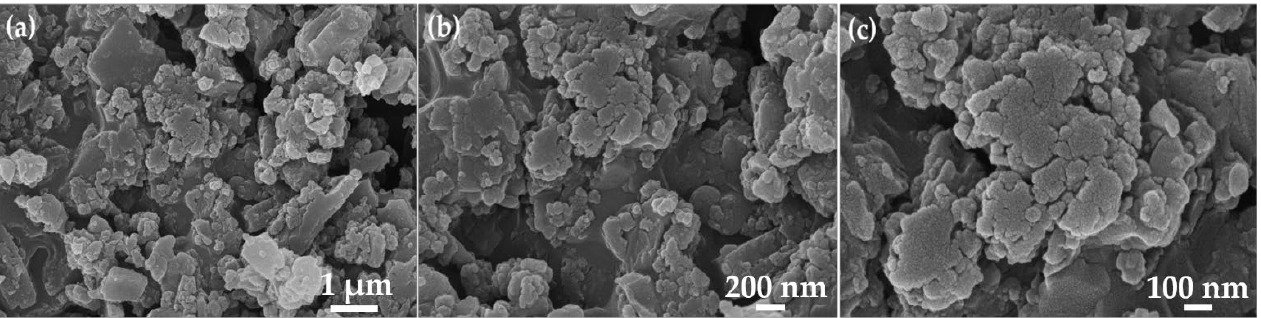
Figure 3. FESEM images of as—synthesized PNA nanoparticles at (a) 1µm, (b) 200 nm and (c) 100 nm magnifications.